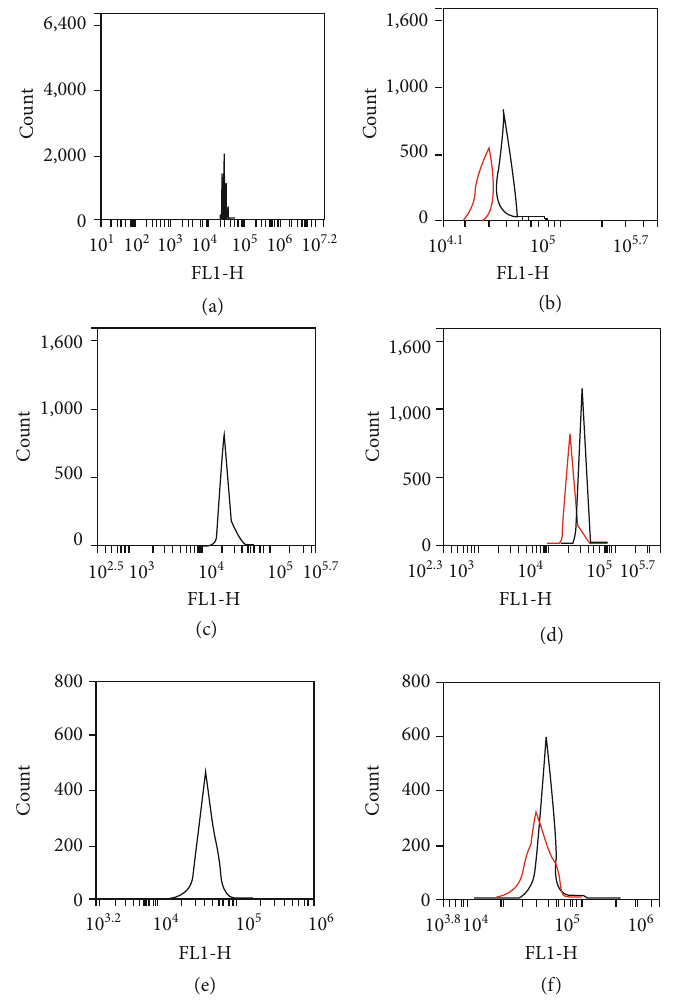
Figure 2: Flow cytometric evaluation of EMA-labeled red blood cells. Experimental procedure was as described in Materials and Methods. The fl uorescence of EMA-stained RBC was obtained for proband I-1 (a), proband II-1 (c), and proband III-1 (e), and their overlay plot compared to the healthy control corresponding to (b), (d), and (f) are shown.